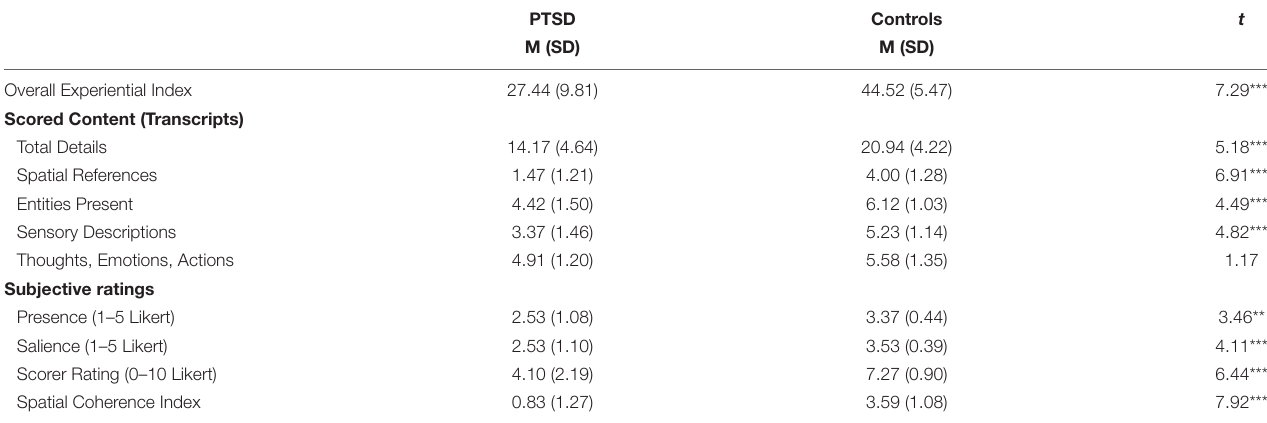
TABLE 3 | Performance on the scene construction task.